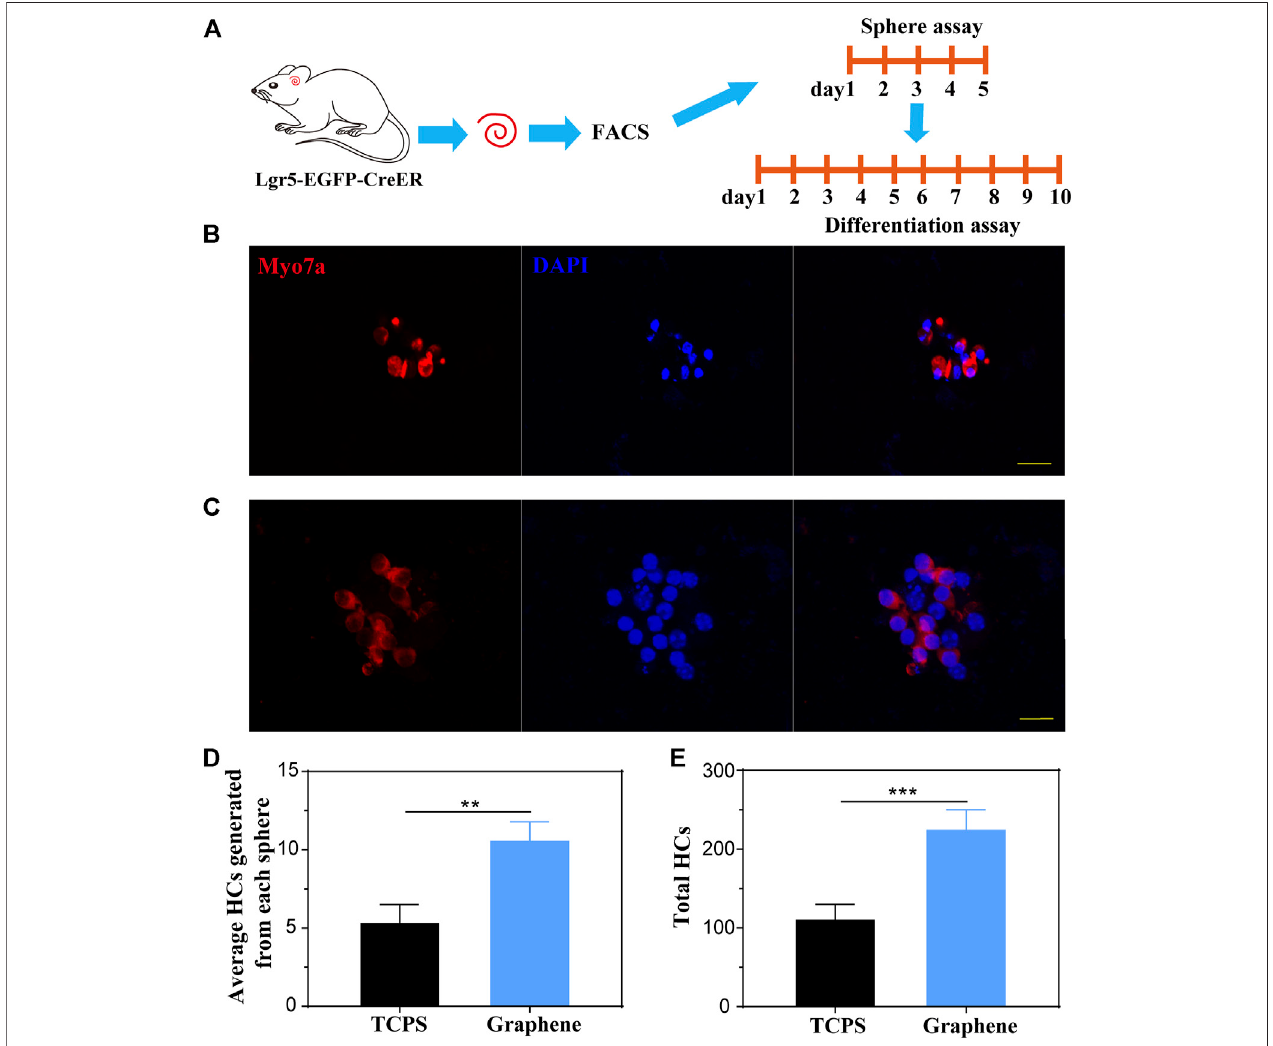
FIGURE 4 | Lgr5+ spheres cultured on graphene substrates generate more HCs compared to those on TCPS. (A) Lgr5+ progenitors were cultured on different substrates for 5 days of sphere assay and 10 days of differentiation assay. (B,C) An Lgr5+ sphere cultured on TCPS (B) and graphene substrates (C) stained with the Myosin7a (red) and DAPI (blue). (D) Quanti fi cation of the average number of HCs differentiated from each sphere. (E) Quanti fi cation of the total number of HCs differentiated from Lgr5+ progenitors per well. The scale bars are 20 μ m in (B,C) .